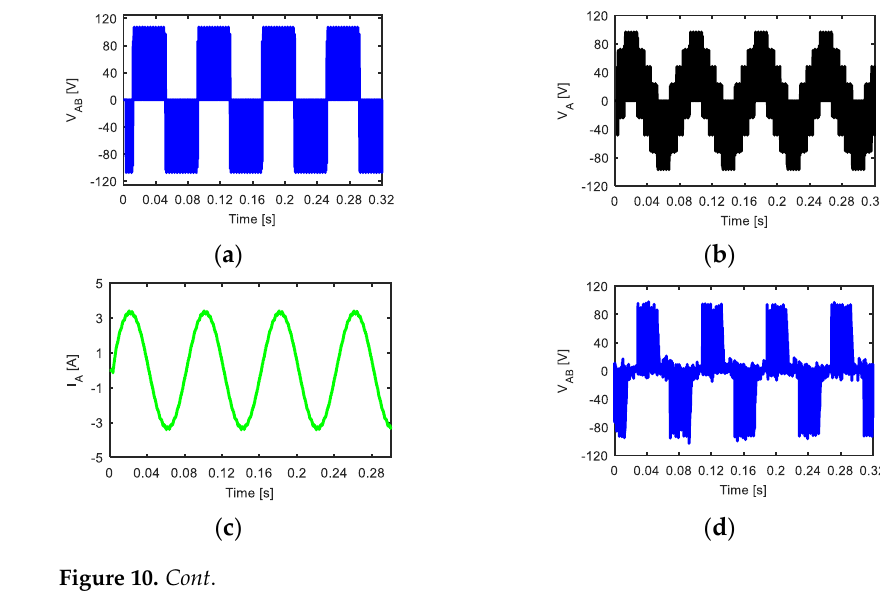
Figure 9. The complete experimental setup.